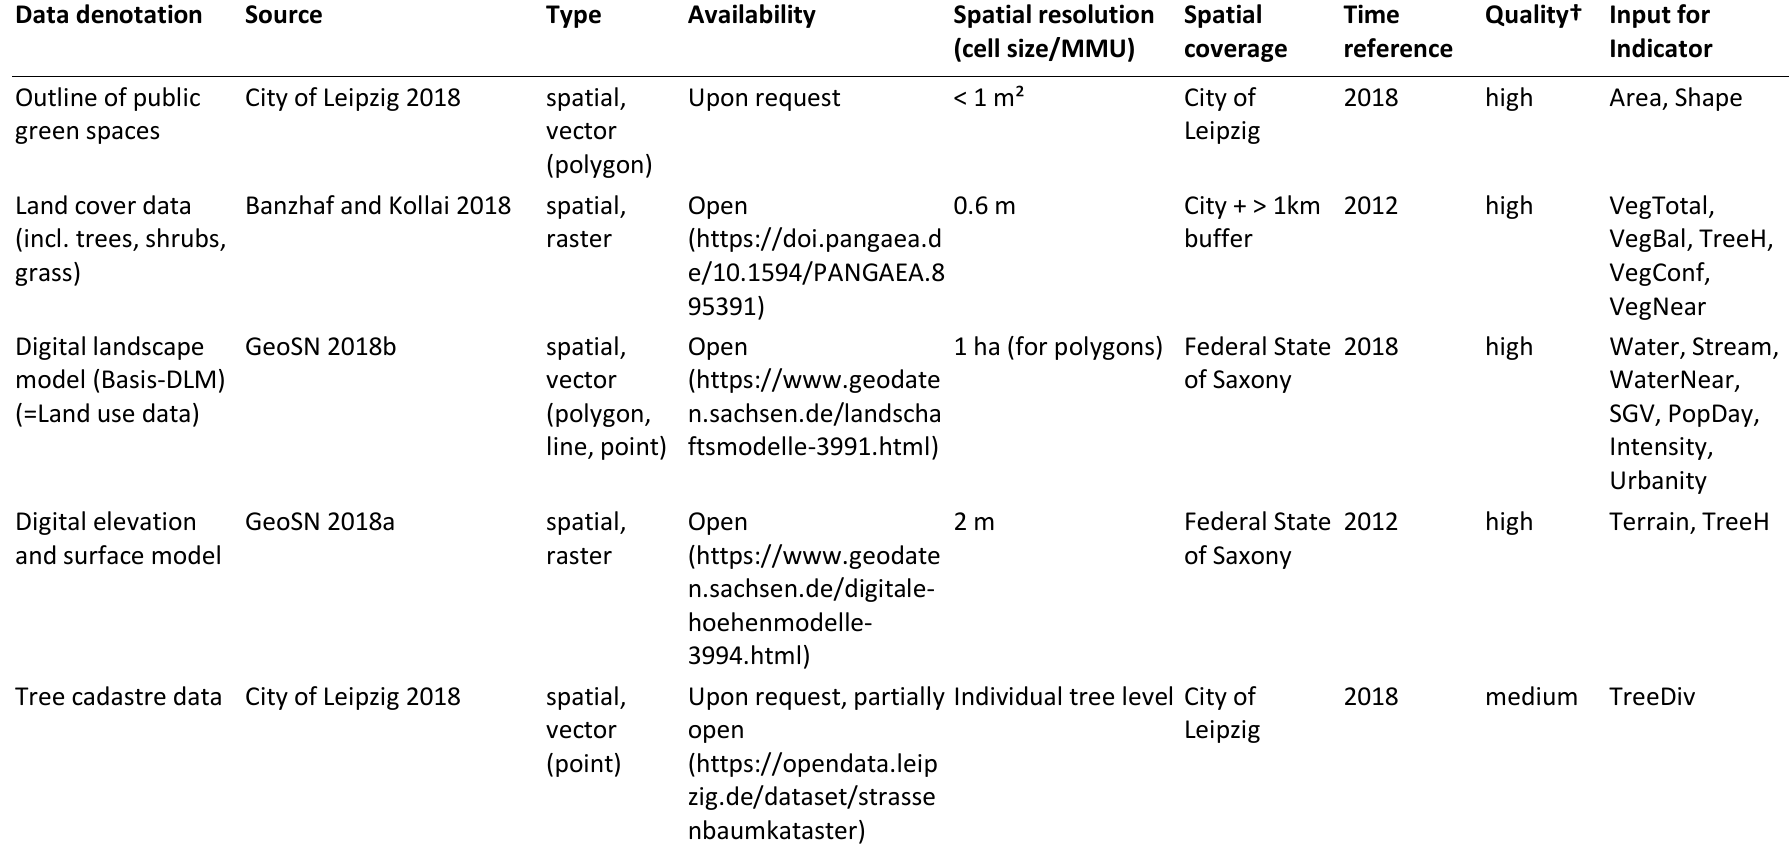
Table A1.1. List of data used to derive park quality indicators and its characteristics. Acronyms used: MMU = minimum mapping unit (for categorical